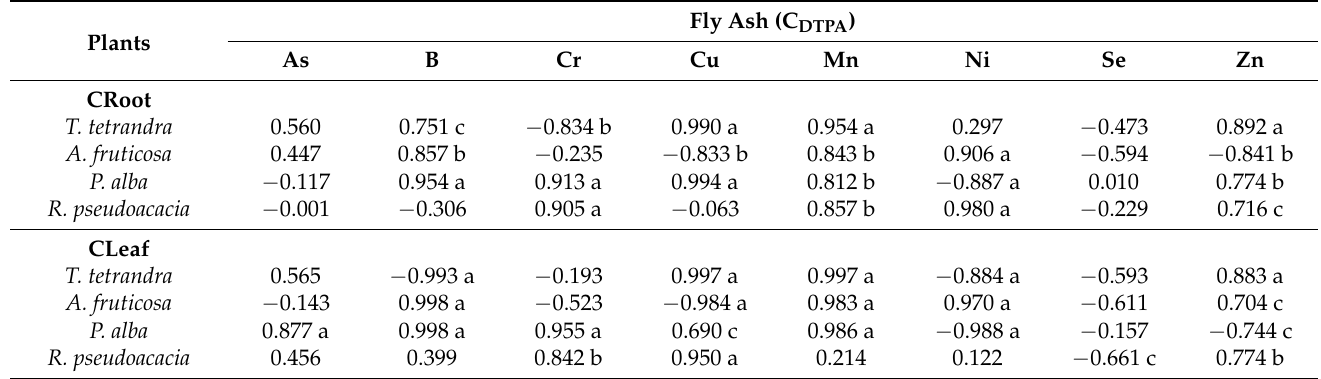
Table 3. Spearman’s correlation coefficient between bioavailable trace element concentrations in FA (C DTPA ) and concentrations in roots (CRoot) and leaves (CLeaf) of the examined woody plant species.